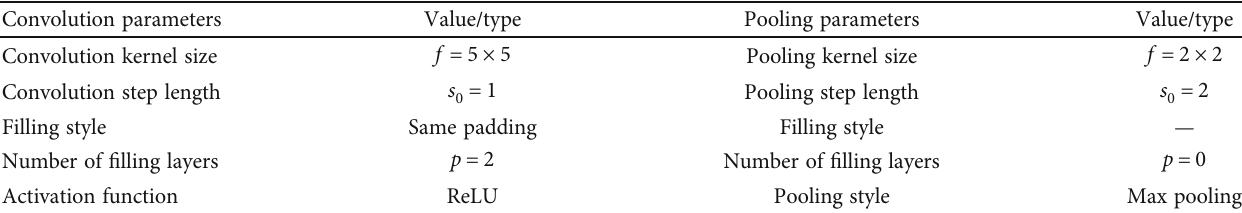
Figure 7: Gas concentration images after blasting with di ff erent K Table 3: The parameters of the outburst risk prediction model based on